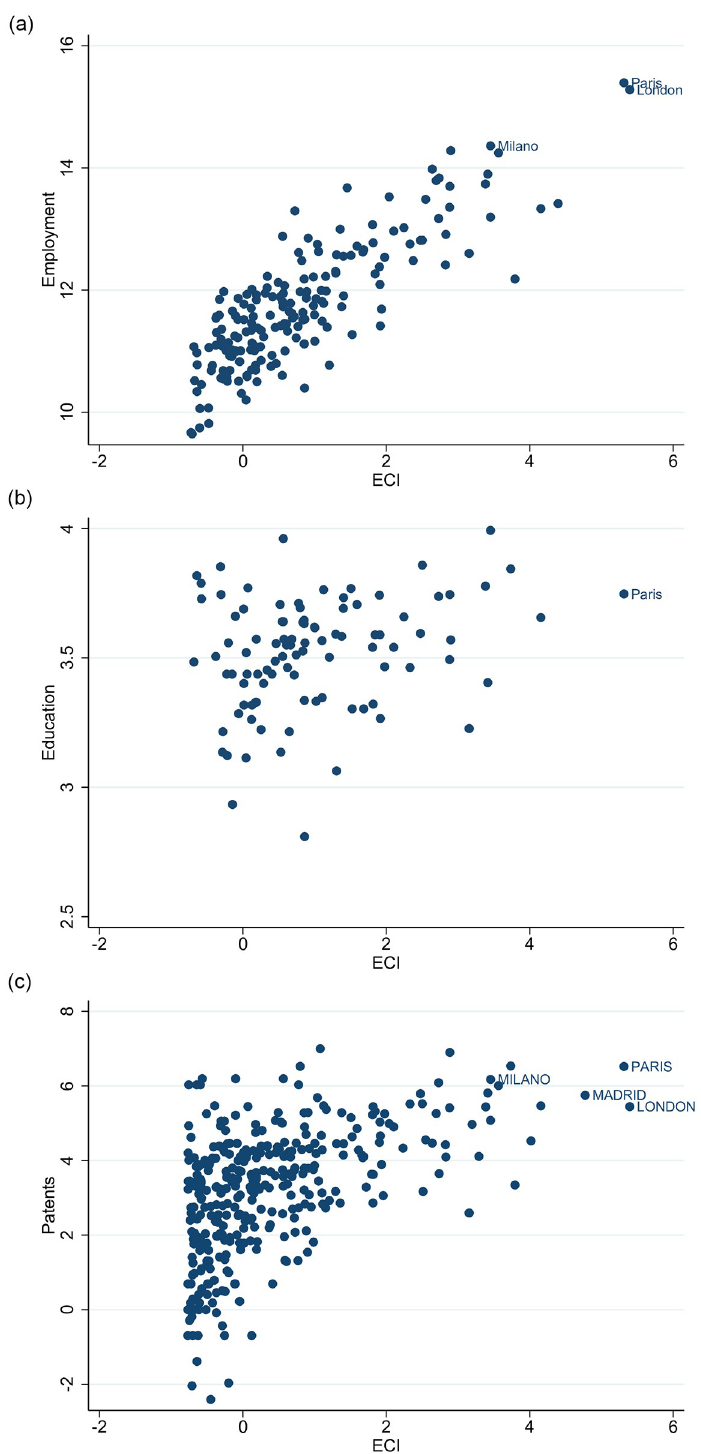
Fig 10. Cities economic complexity (ECI), employment, education and innovation. [a] ECI vs Total employment; [b] ECI vs Tertiary education; [c] ECI vs Patents. The figures have been generated using StataSE 14.